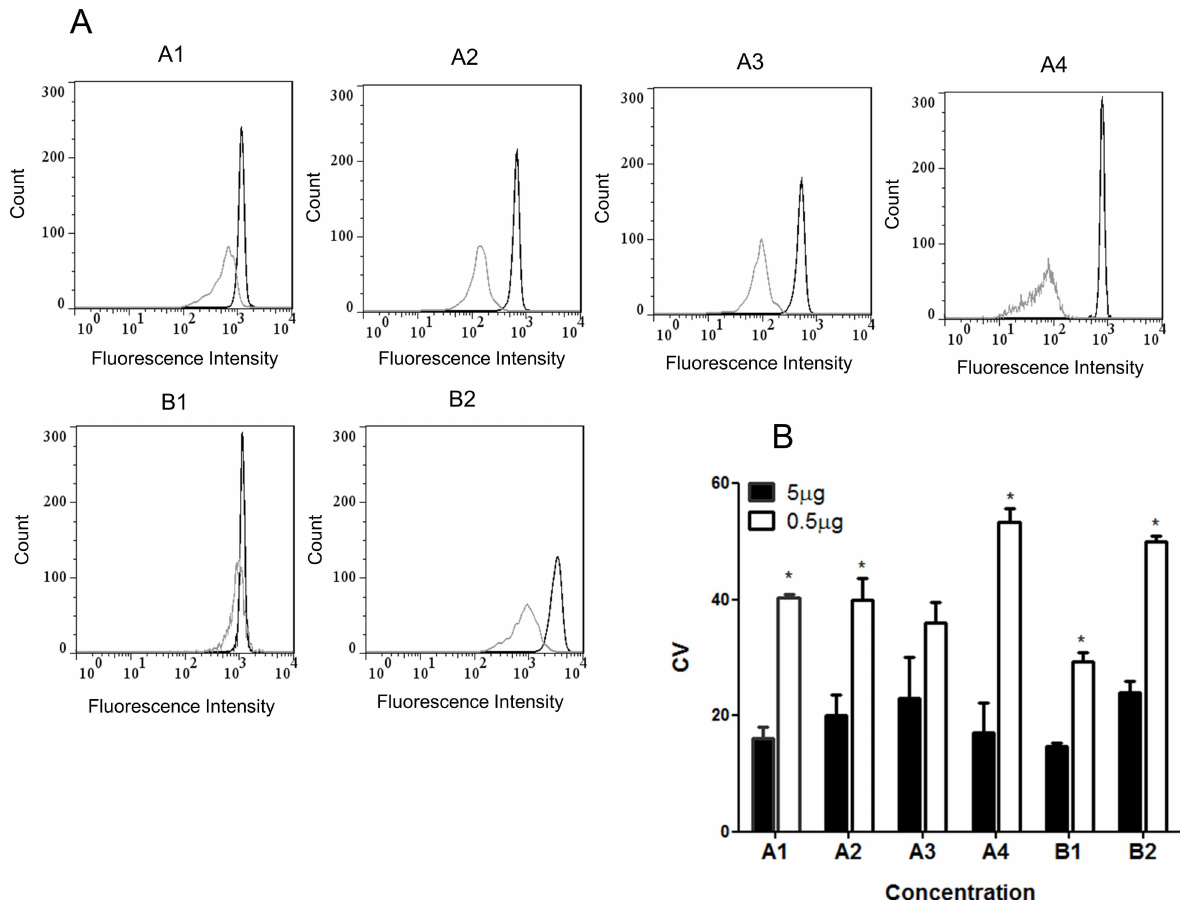
Fig 3. Staining profile of anti-IgG-PE conjugates. A: Representative histograms of PE-fluorescence intensity (X axis) vs. count (Y axis). 0.5 μ g/mL = white peak and 5 μ g/mL = black peak. B: Coefficientof variationof 0.5 μ g/mL (white bars) and 5 μ g/mL (black bars). Data expressedas the means of CVs from of three tests ± standard deviation. T test was performed for group comparison. An asterisk indicatesa significantly different value assumed at p (cid:20) 0.05.